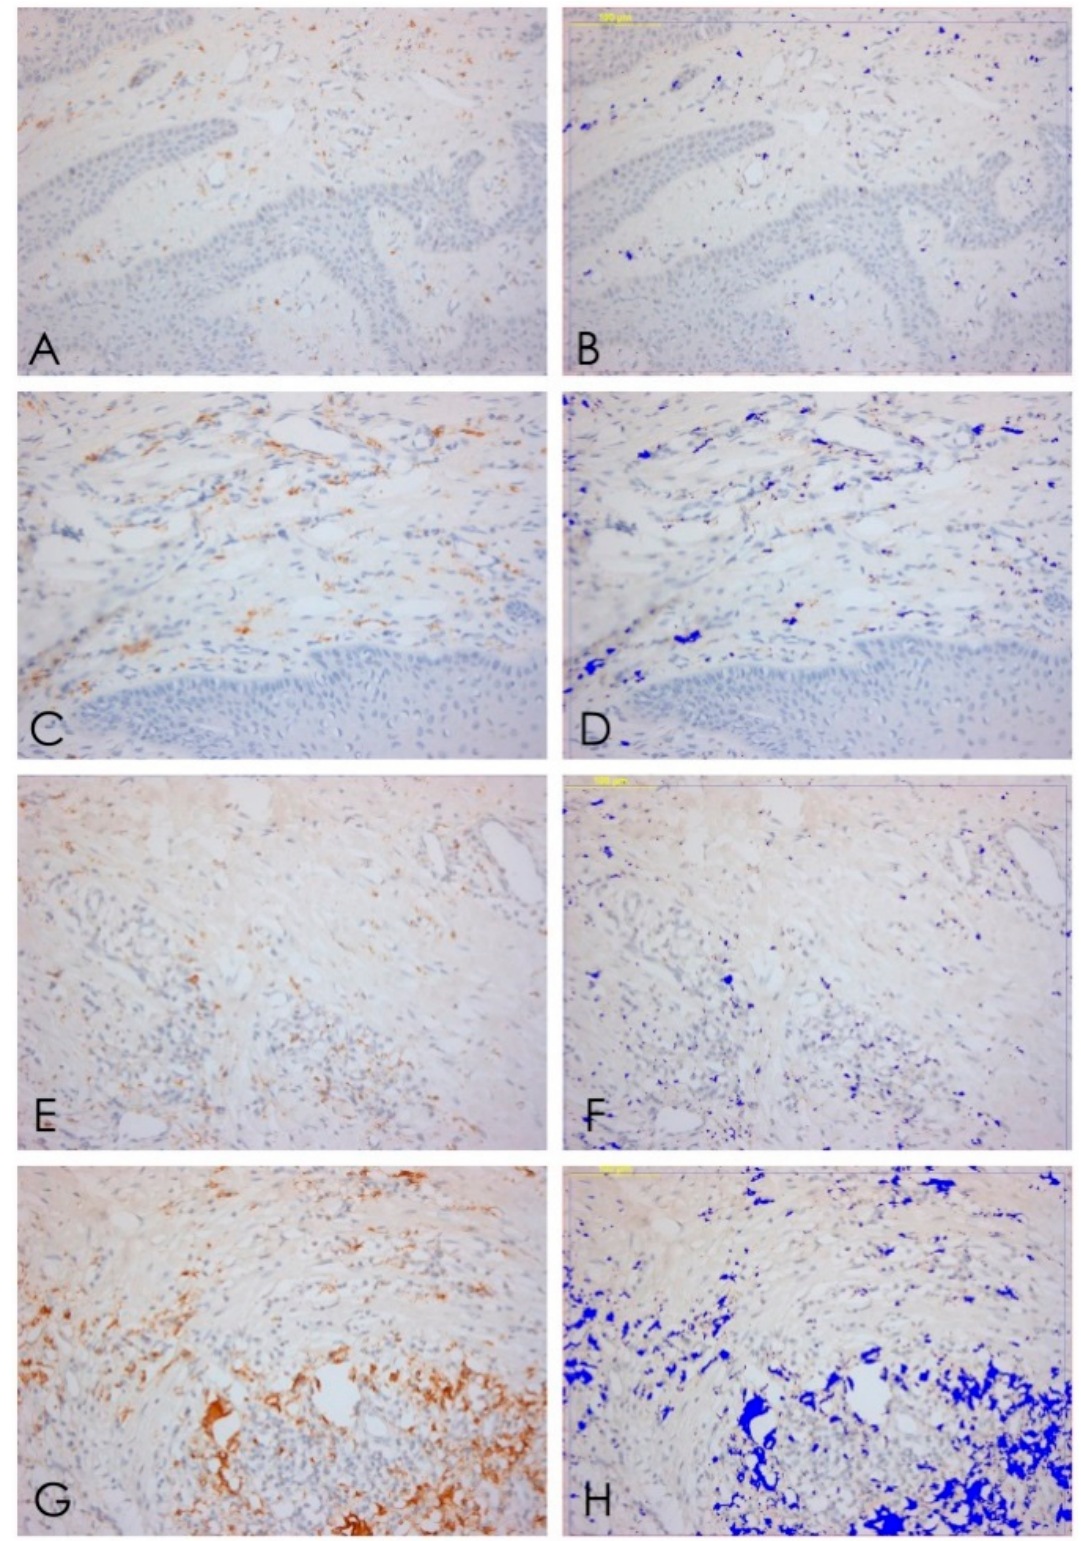
Figure 6. CD68. ( A , B ) Macrophages expression T1, 20 × ABC, and software analysis; ( C , D ) macrophages expression T2, 20 × ABC, and software analysis; ( E , F ) macrophages expression T3, 20 × ABC, and software analysis; ( G , H ) macrophages expression T4, 20 × ABC, and software analysis.